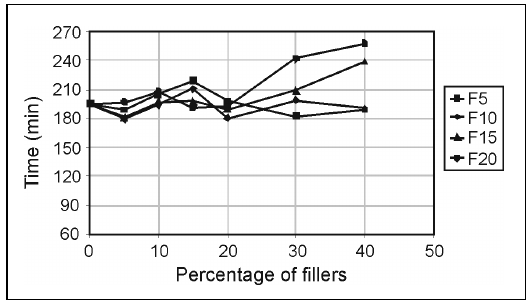
Fig. 5. Final setting time